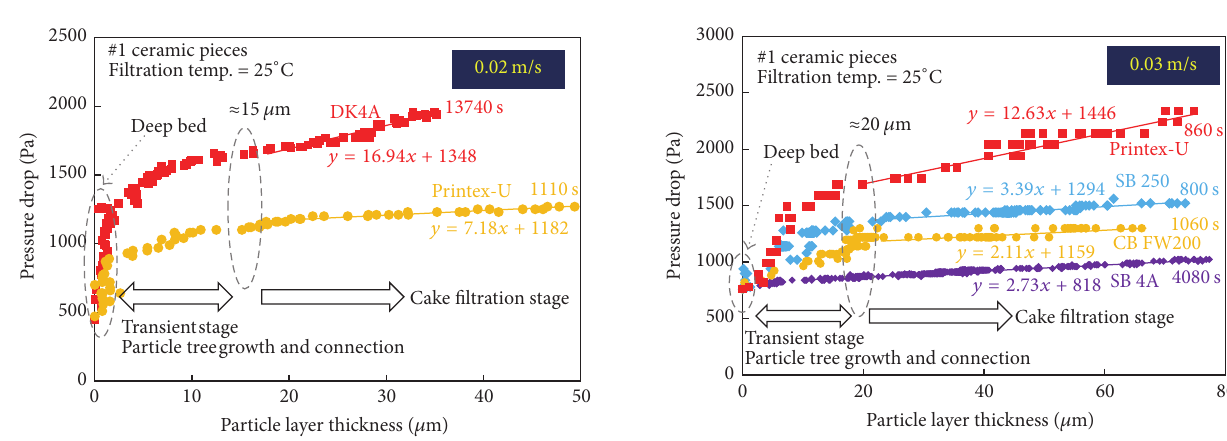
Figure12:Thepressuredropofceramicpieceswiththeparticlelayer thickness.